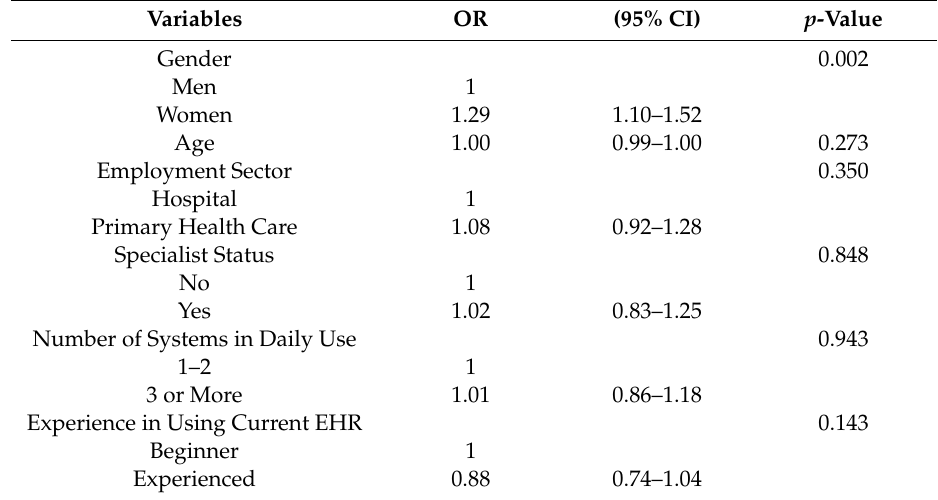
Table 3. The results of the logistic regression analysis for self-rated stress, Odds Ratios (ORs) and their 95 percent Confidence Intervals (95%